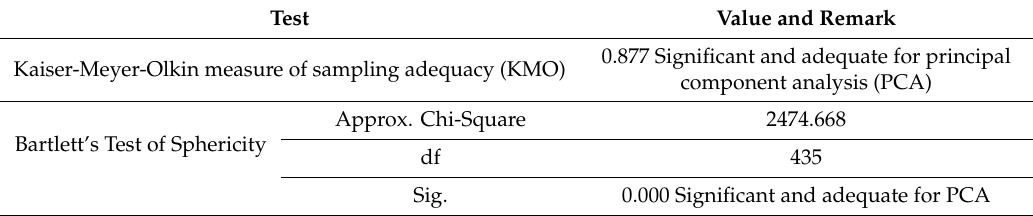
Table 3. Kaiser-Meyer-Olkin measure of sampling adequacy (KMO) and Barlett’s Test of Sphericity to confirm fittingness of factors for